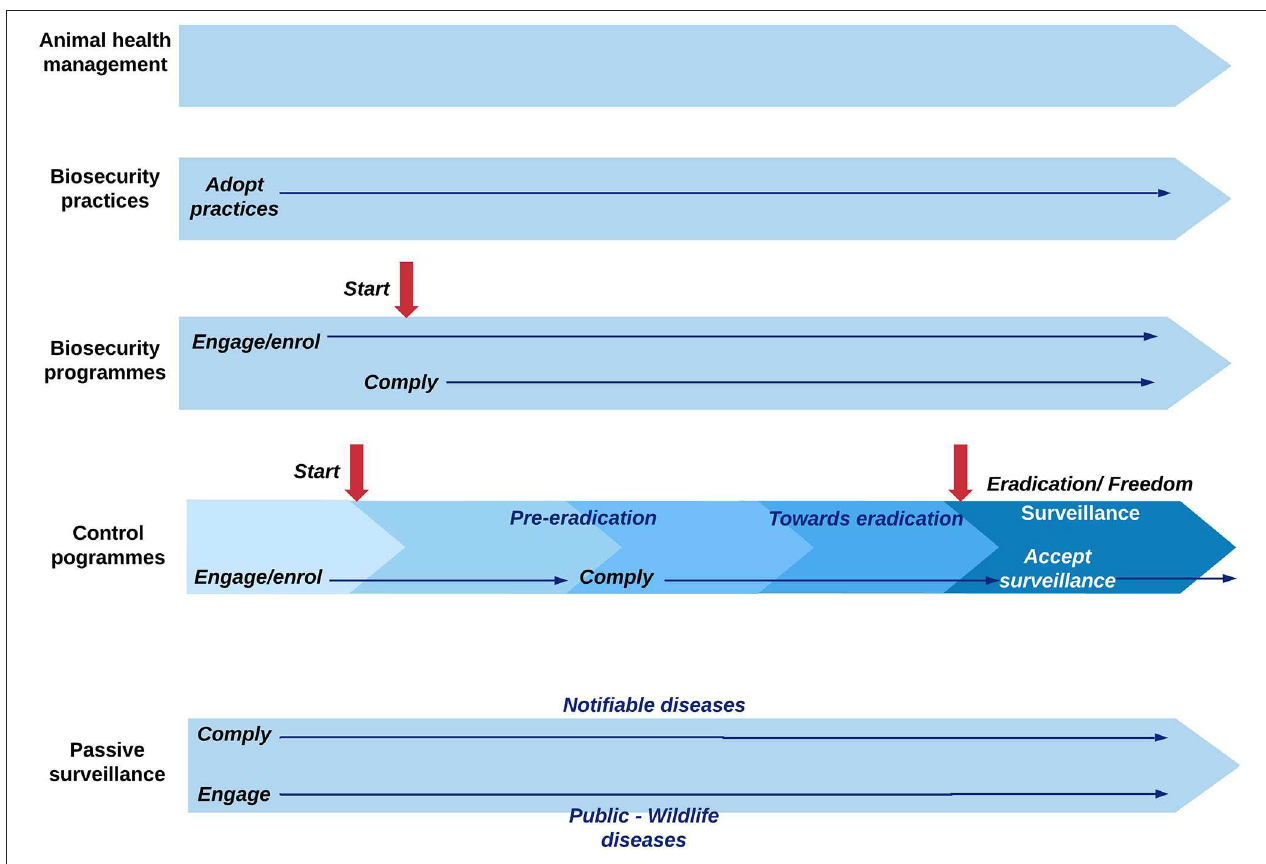
FIGURE 1 | Overview of the timeline of animal health activities in relation to the application of strategies to achieve a behavior of